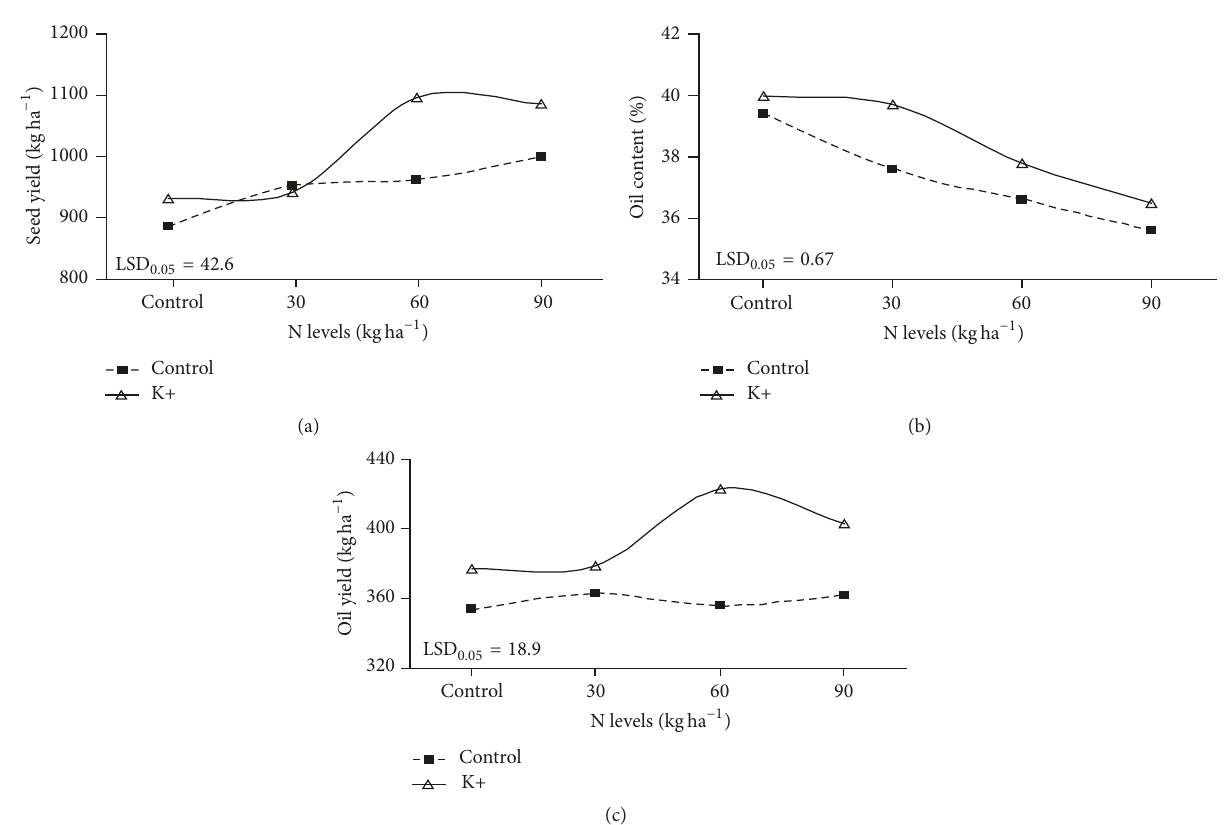
experimental years was determined in seed yield, oil content, and oil yield (Table 2). Mean seed yield, oil content, and oil yield were higher in the first year compared to the second year. This may be explained by higher precipitation and lower temperature in 2011 relative to 2012. The average temperature was 14.8 ∘ C in 2011 and 15.3 ∘ C in 2012. The total precipitation amount in the first experimental season (March–August) was higher (223.9 mm), and its distribution was more uniform than that in the second year (168.4 mm). Thus, higher seed yield, oil content, and oil yield were obtained in